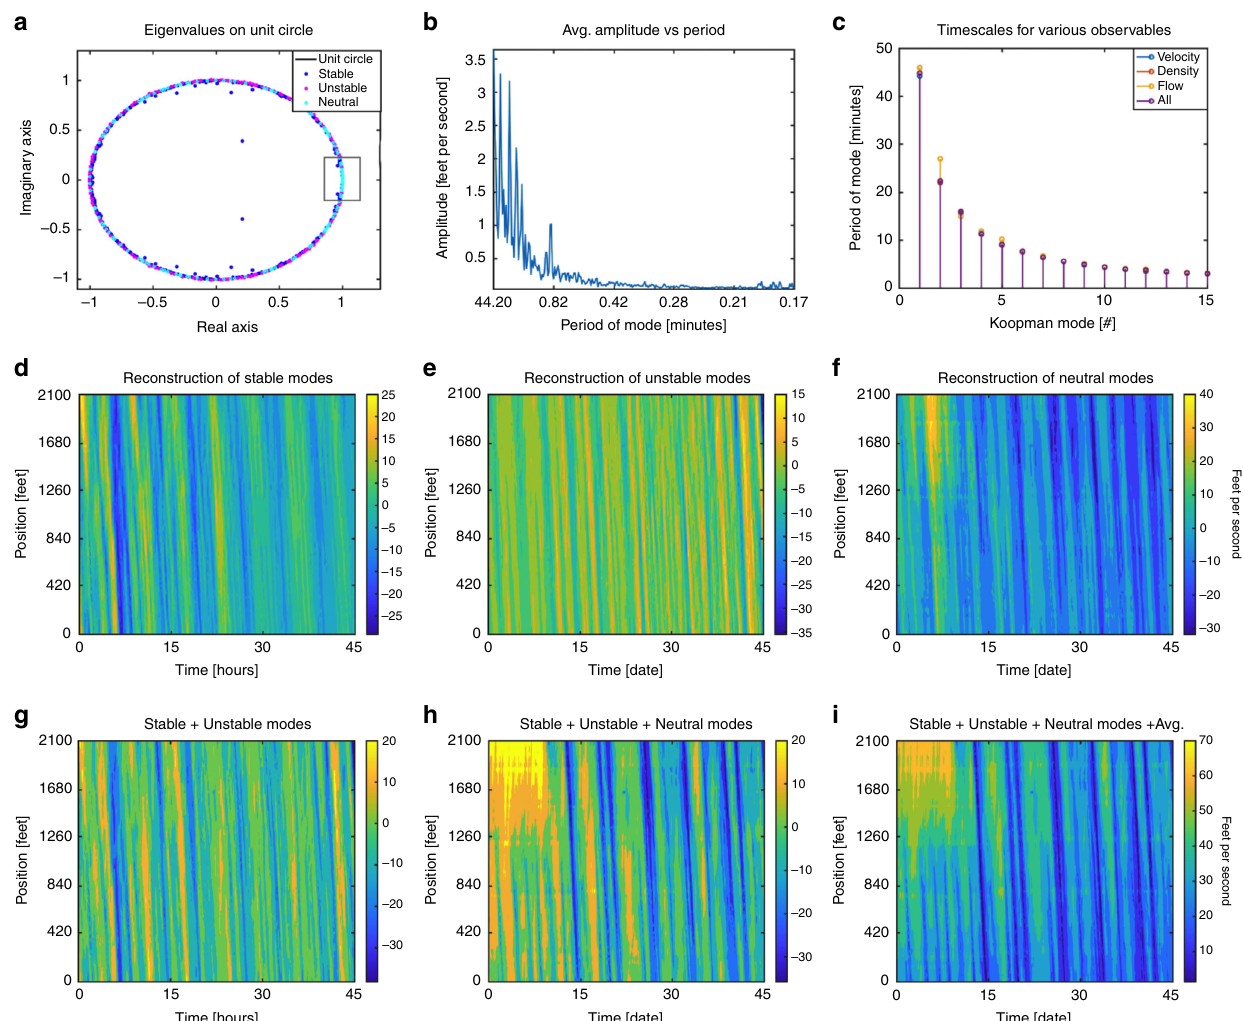
Fig. 4 Koopman eigenvalue analysis and the corresponding stable, unstable, and neutral modes. a Plotting the color-coded eigenvalues on the unit circle con fi rms the fi ndings of Kim 59 in that slowly evolving patterns persist in time. b Plotting the average amplitude of the modes against their period con fi rms the fi ndings of Gartner 60 in that slower evolving patterns carry larger amplitudes. c Plotting the timescales identi fi ed for various choices of data demonstrates the KMD to be a robust methodology for extracting fundamental frequencies regardless of the modality of observation and verify the existence of intra-day patterns. d – i Plots of the corresponding stable, unstable, and neutral modes and various superpositions of them. These fi gures verify that the individual modes correspond to coherent and dynamically important sub-patterns and when superimposed reconstruct the (Fig. 9b) along with the average phase and magnitude (Fig. 9c, d). The red horizontal lines in Fig. 9d serve to visually divide the data corresponding to differing highways. From the 24-hour mode itself, we can immediately observe that the onset of congestion occurs in a certain order within the network. Speci fi cally, the I- 105W, I-10W, and I-405N are congested fi rst then the I-710N followed by the I-110N. One can conclude this by observing that the (green) areas of congestion for every highway are staggered, the order of their staggering reveals the order in which they are congested. The order of congestion indicated corresponds with the well-known fact that morning traf fi c travels in the direction of Los Angeles from San Bernardino County (east to west) and from Orange county (southeast to northwest). This is further veri fi ed by observing the near equal phases for the west and northbound directions coming into LA (Fig. 9c) and the near equal, but